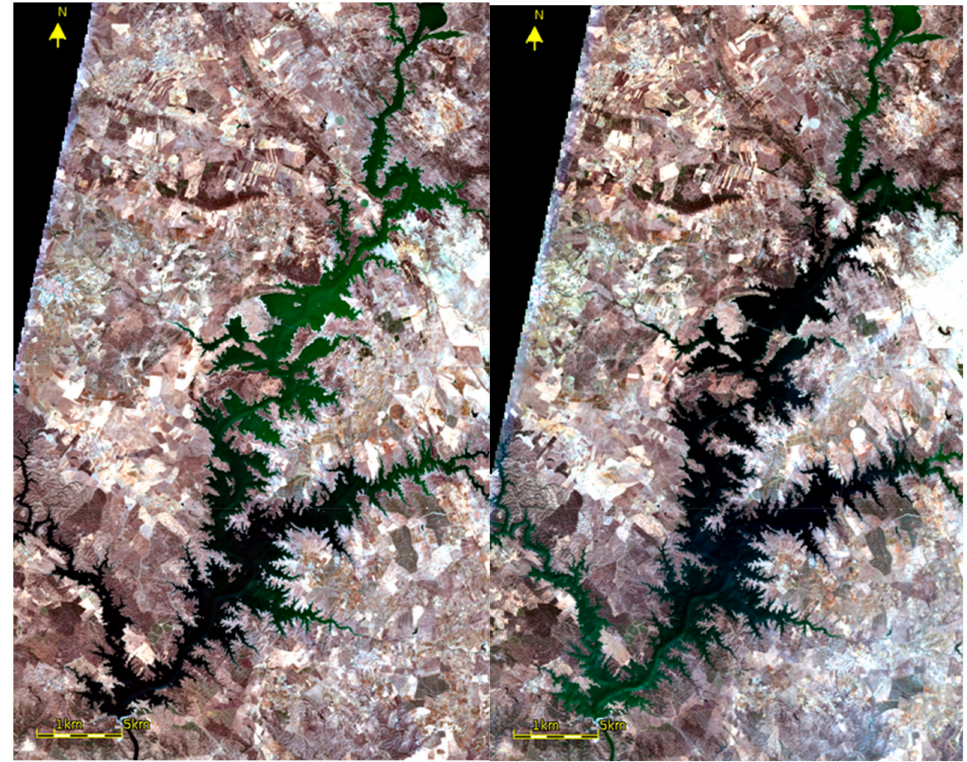
Figure 13. RGB Images showing a microalgae bloom for 19 September 2017 (left) and for 19 September 2018 (right) in the Alqueva